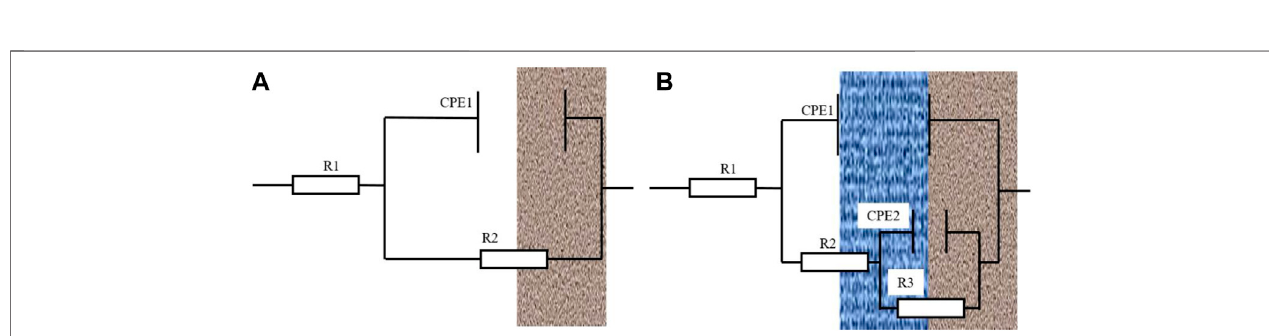
FIGURE 7 | (A) is the equivalent circuit diagram fi tted with a time constant, and (B) is the equivalent circuit diagram fi tted with two time constants.